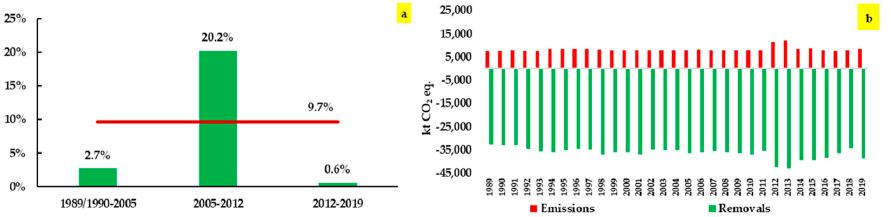
Figure 6. ( a ) Contribution of the Romanian LULUCF sector to net GHG removals from EU-27 + United Kingdom (Calculation was made as a percentage ratio between the absolute change in removals in Romania and the absolute change in net removals at the UK-27 + UK’s level); ( b ) GHG emissions vs. GHG removals comparative dynamics for Romania.